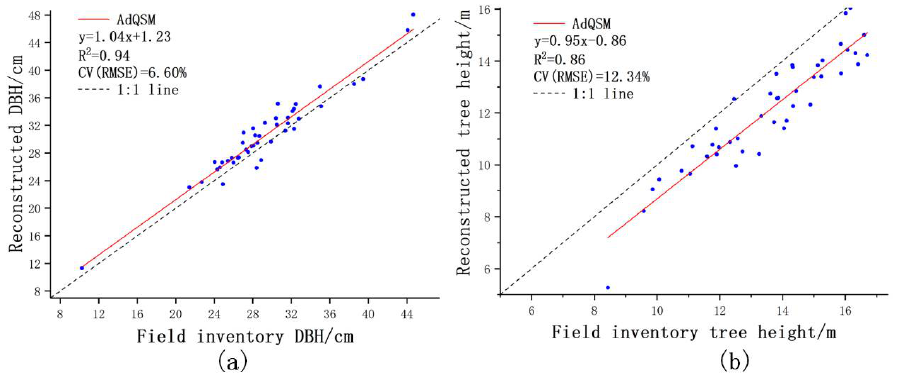
Figure 11. Comparison of DBH and tree height estimated by AdQSM with reference values of field measured: ( a ) DBH, ( b ) tree height.